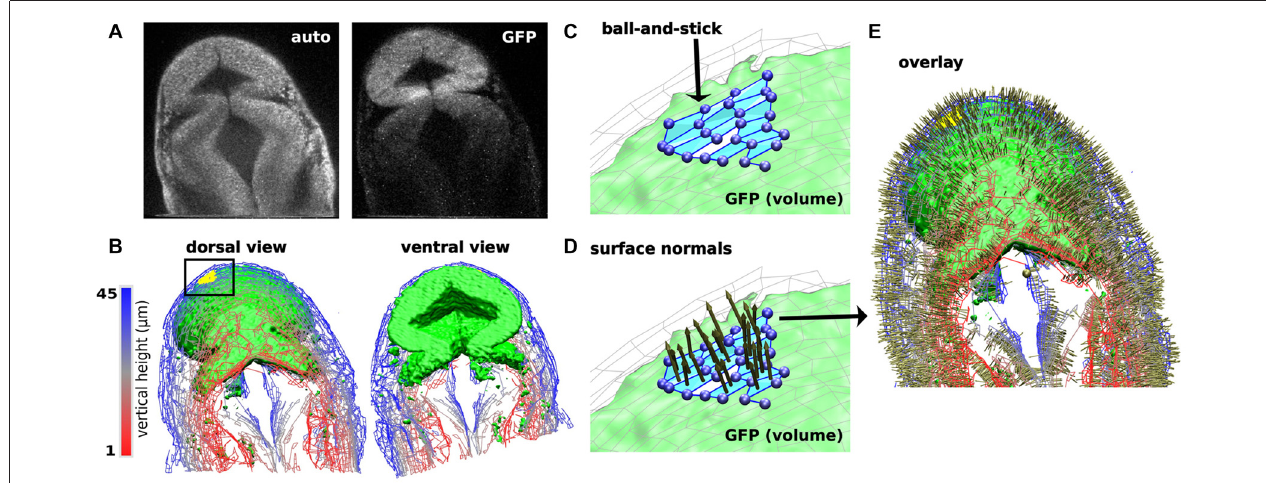
FIGURE 6 | Computer Aided Feature Extraction (CAFE) reconstruction of zebrafish brain embryo images. (A) Single slice 2-photon microscope images of zebrafish brain embryo at 20 hpf displaying autofluorescence (left) and GFP (right) channels. GFP channel marks wnt1 expression. (B) Zebrafish embryo structure representation of autofluorescence (wires) and GFP (green volume). Visualizing images 1–45 in the 79-image stack in dorsal (left) and ventral (right) views. Autofluorescence (wires) reconstructed using boundary-based detection function to recognize local pixel gradients and define ball-and-stick model along the edges of the image. GFP (green volume) reconstructed using an area-based detection function to place balls in areas of high pixel intensity. (C) Detailed ball-and-stick model of boxed region in (B) showing CAFE-defined morphological surface (light blue). (D) Local surface normals for surfaces highlighted in (C) . (E) Dorsal view of overlay of autofluorescence and GFP reconstructions with surface